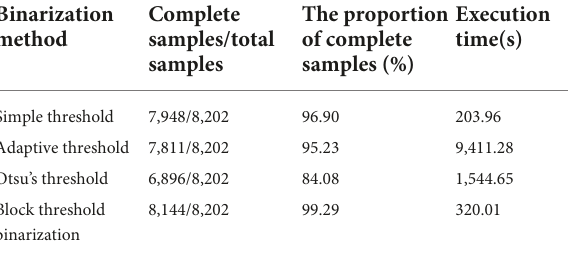
TABLE 4 Performance evaluation table of different threshold methods.